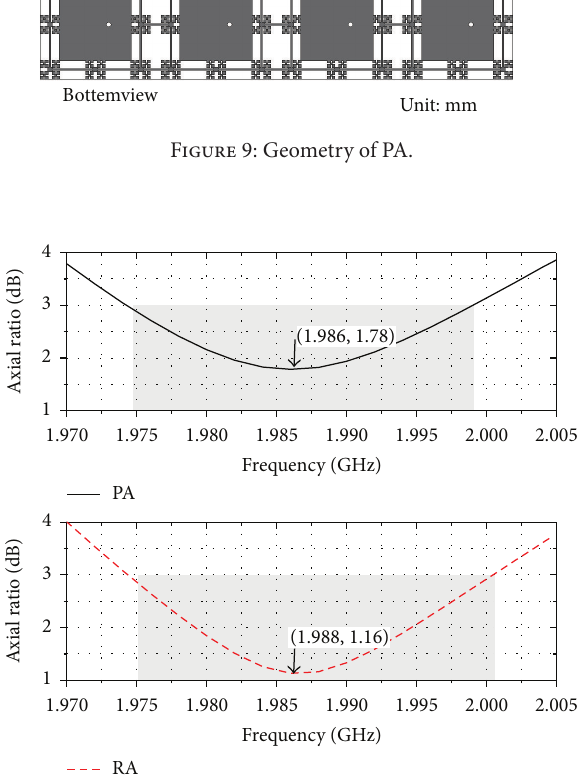
Figure 10: Axial ratio curves of PA and